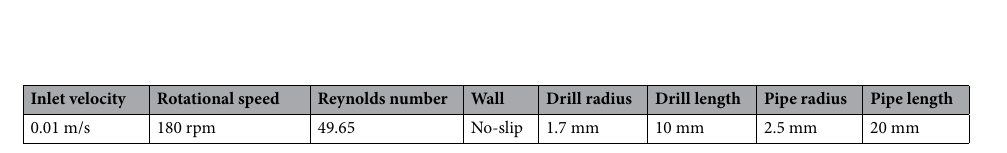
Table 2. Computational conditions and dimensions of domain for CFD simulation.